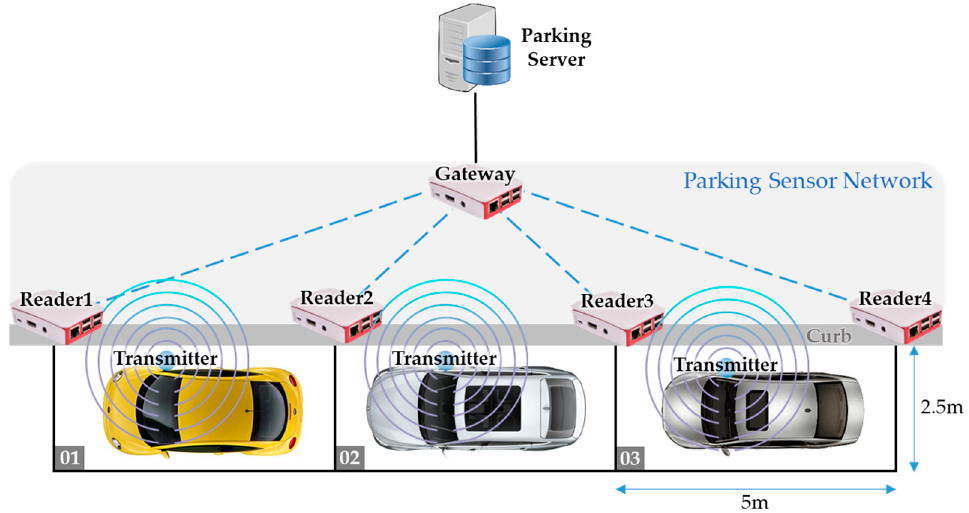
Figure 2. The proposed system architecture.